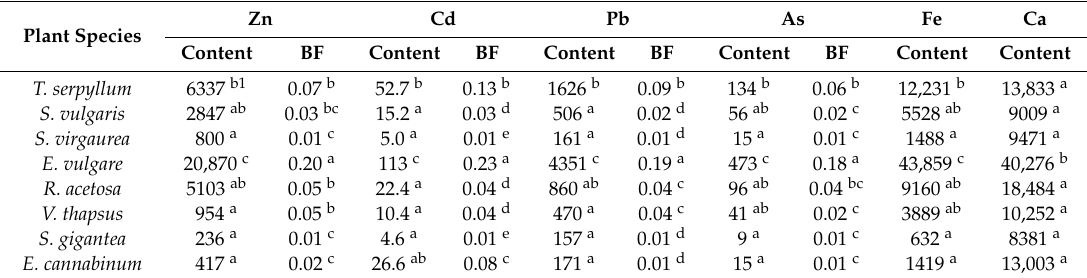
Table 3. Chemical composition of plants inhabiting FW and SW soils (mg kg − 1 ) and bioconcentration factors (BF) for potentially toxic trace elements